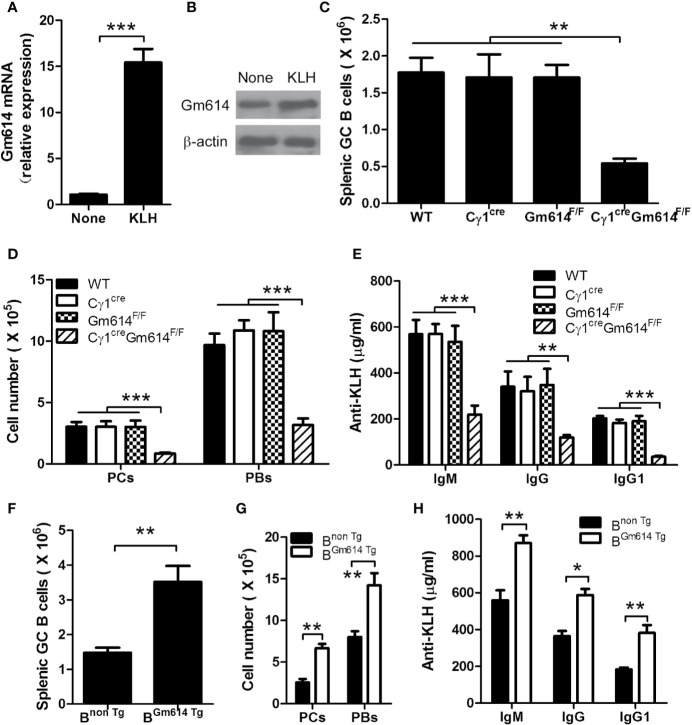
Gm614 up-regulated GC B-cell responses induced by foreign antigen KLH. Nine-week-old WT, Cγ1cre (Cγ1-cre), Gm614F/F (Gm614fl/fl), and Cγ1creGm614F/F (Gm614 cKO), or Bnon Tg and BGm614 Tg mice were i.p. injected with 100 μg of the protein antigen KLH in a volume of 0.2 mL of saline and analyzed after 28 days. (A, B) Gm614 expression was up-regulated in GC B cells by foreign antigen KLH. GC B cells from splenocytes of six nonimmunized WT mice and KLH-immunized WT mice were sorted by FACS, and subjected to qPCR (A) and western blot (B) analysis. (C–E) Gm614 cKO suppressed GC B-cell responses induced by KLH. Splenocytes and sera were collected from KLH-immunized WT, Cγ1cre, Gm614F/F, and Cγ1creGm614F/F mice. Splenic CD19+B220+CD38loGL7hi GC B cells, CD138+B220+ PBs, and CD138-B220+ PCs cells were analyzed and the absolute number of GC B cells (C), and PBs and PCs (D) was shown. Anti-KLH IgM, IgG, and IgG1 were determined in the sera using ELISA assay (E). (F–H) Gm614 Tg promoted GC B-cell responses induced by KLH. Splenocytes and sera were collected from KLH-immunized Bnon Tg and BGm614 Tg mice. Splenic CD19+B220+CD38loGL7hi GC B cells, CD138+B220+ PBs, and CD138-B220+ PCs cells were analyzed and the absolute number of GC B cells (F), and PBs and PCs (G) was shown. Anti-KLH IgM, IgG, and IgG1 were determined in the sera using ELISA assay (H). (A–H) Data represent three independent experiments, with six samples per group per experiment. Two-Way (D, E, G, H) and One-Way (C) ANOVA was followed by Bonferroni post-tests and two tailed Student’s t-test (A, F), Error bars, s.e.m., *p < 0.05, **p < 0.01, ***p < 0.001.